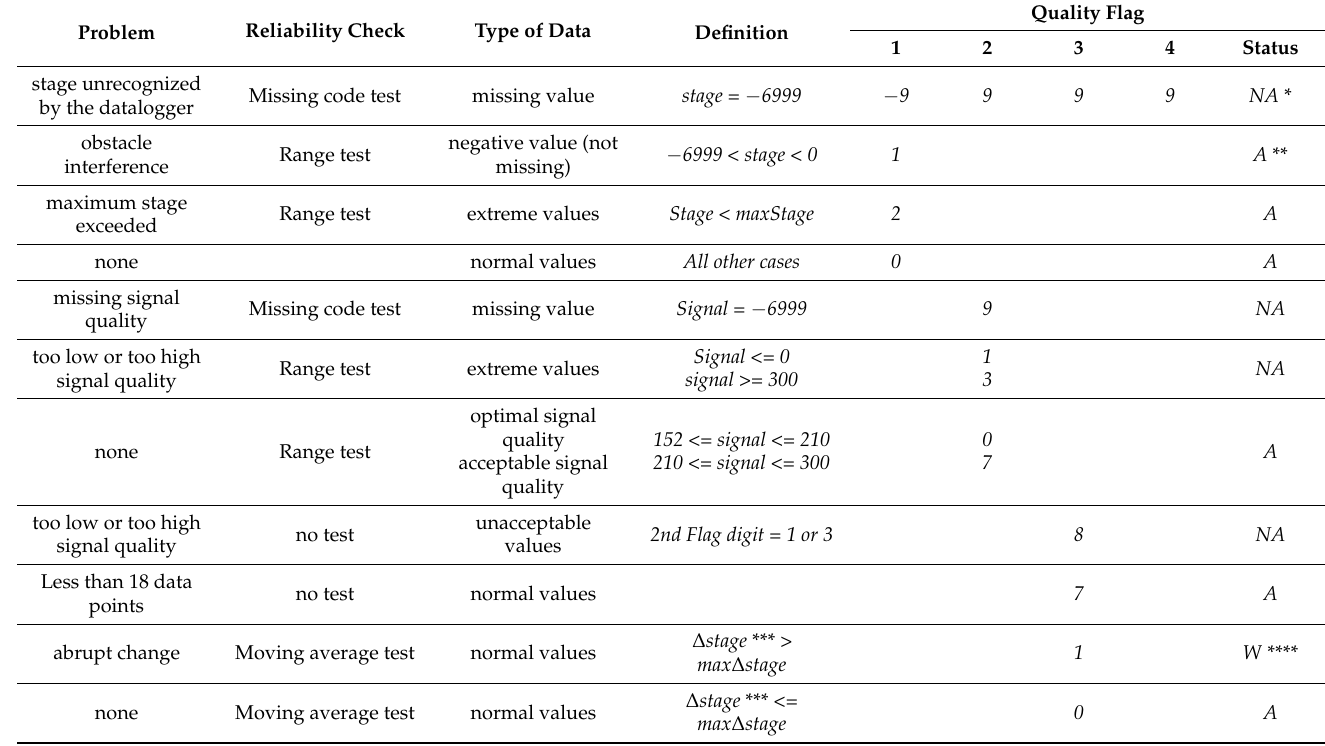
Table 1. Quality tests applied on the stage data recorded by NOA’s automatic